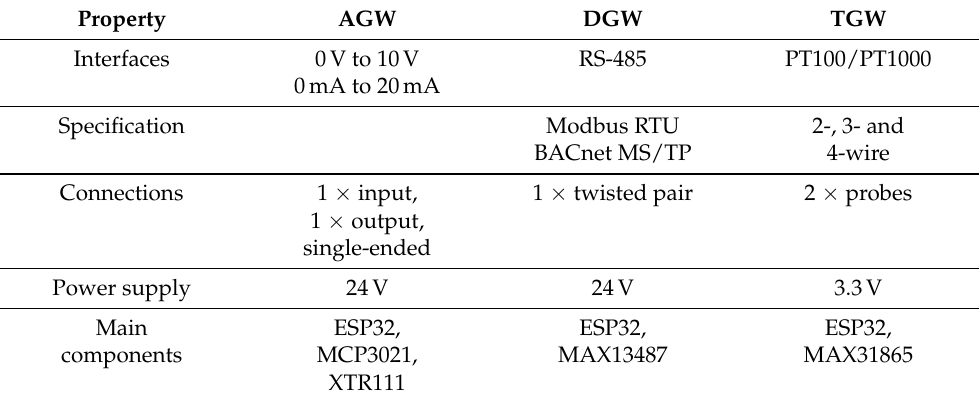
Table 1. Property summary of the three different